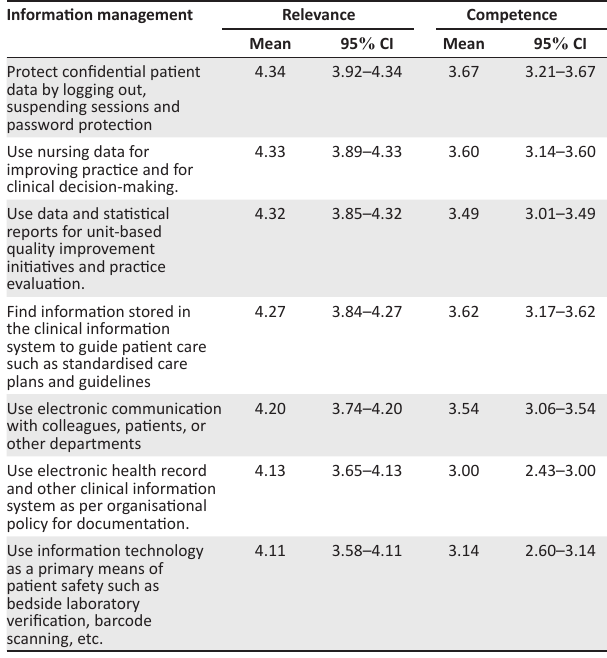
TABLE 3: Information management skills. TABLE 2: Informatics literacy